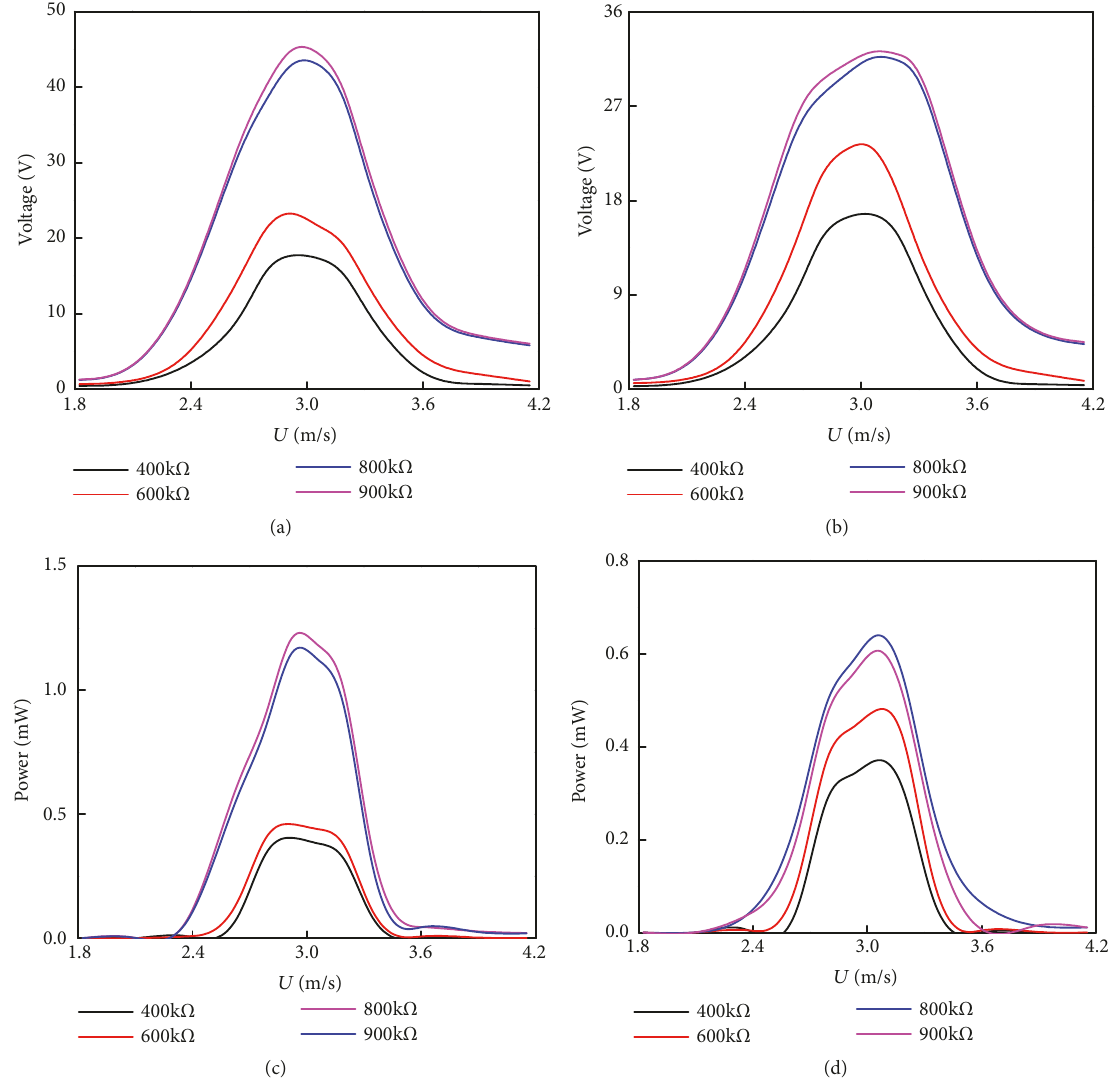
Figure 8: The power-wind and voltage-wind curve of the energy harvester of the pit bionic and smooth structure:(a) the voltage-wind curve of the pit structure; (b) the voltage-wind curve of the smooth cylinder; (c) the power-wind curve of the pit structure; (d) the power-wind curve of the smooth